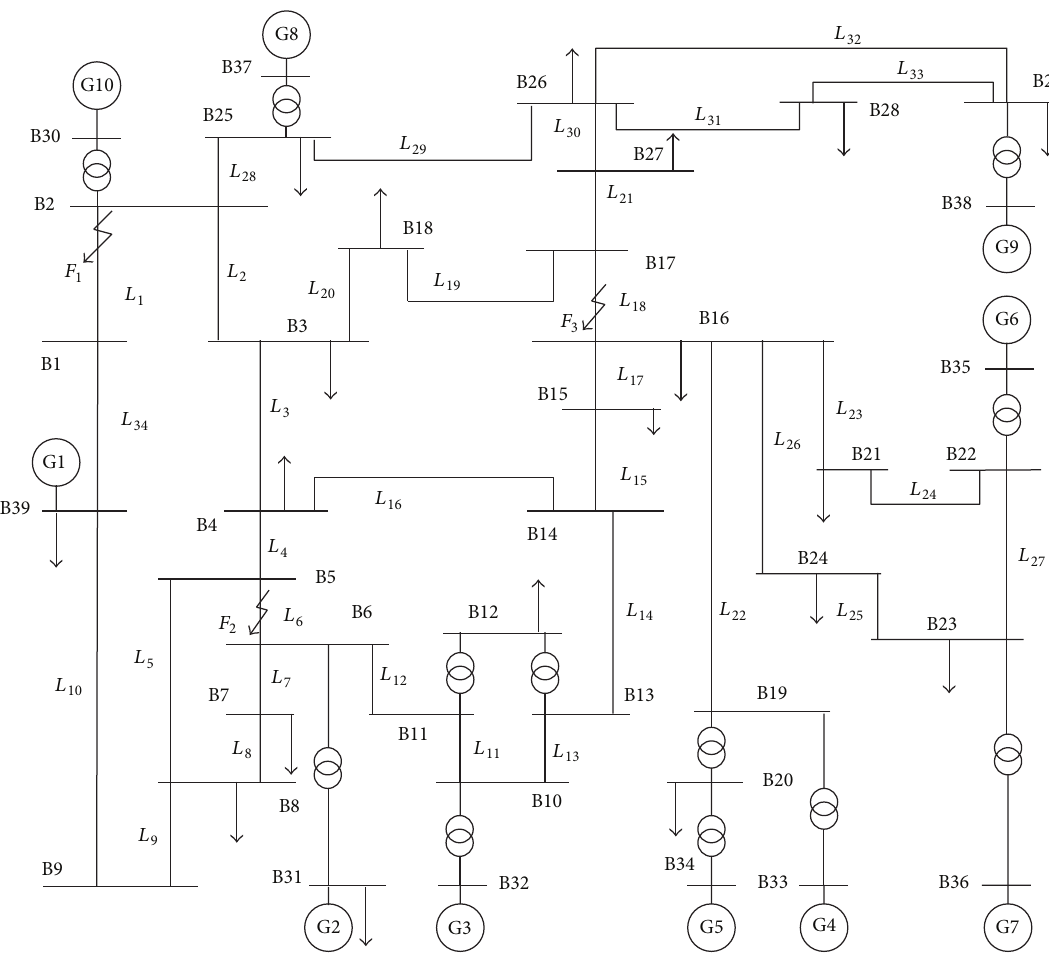
Figure 4: Model of IEEE 10-generator-39-bus